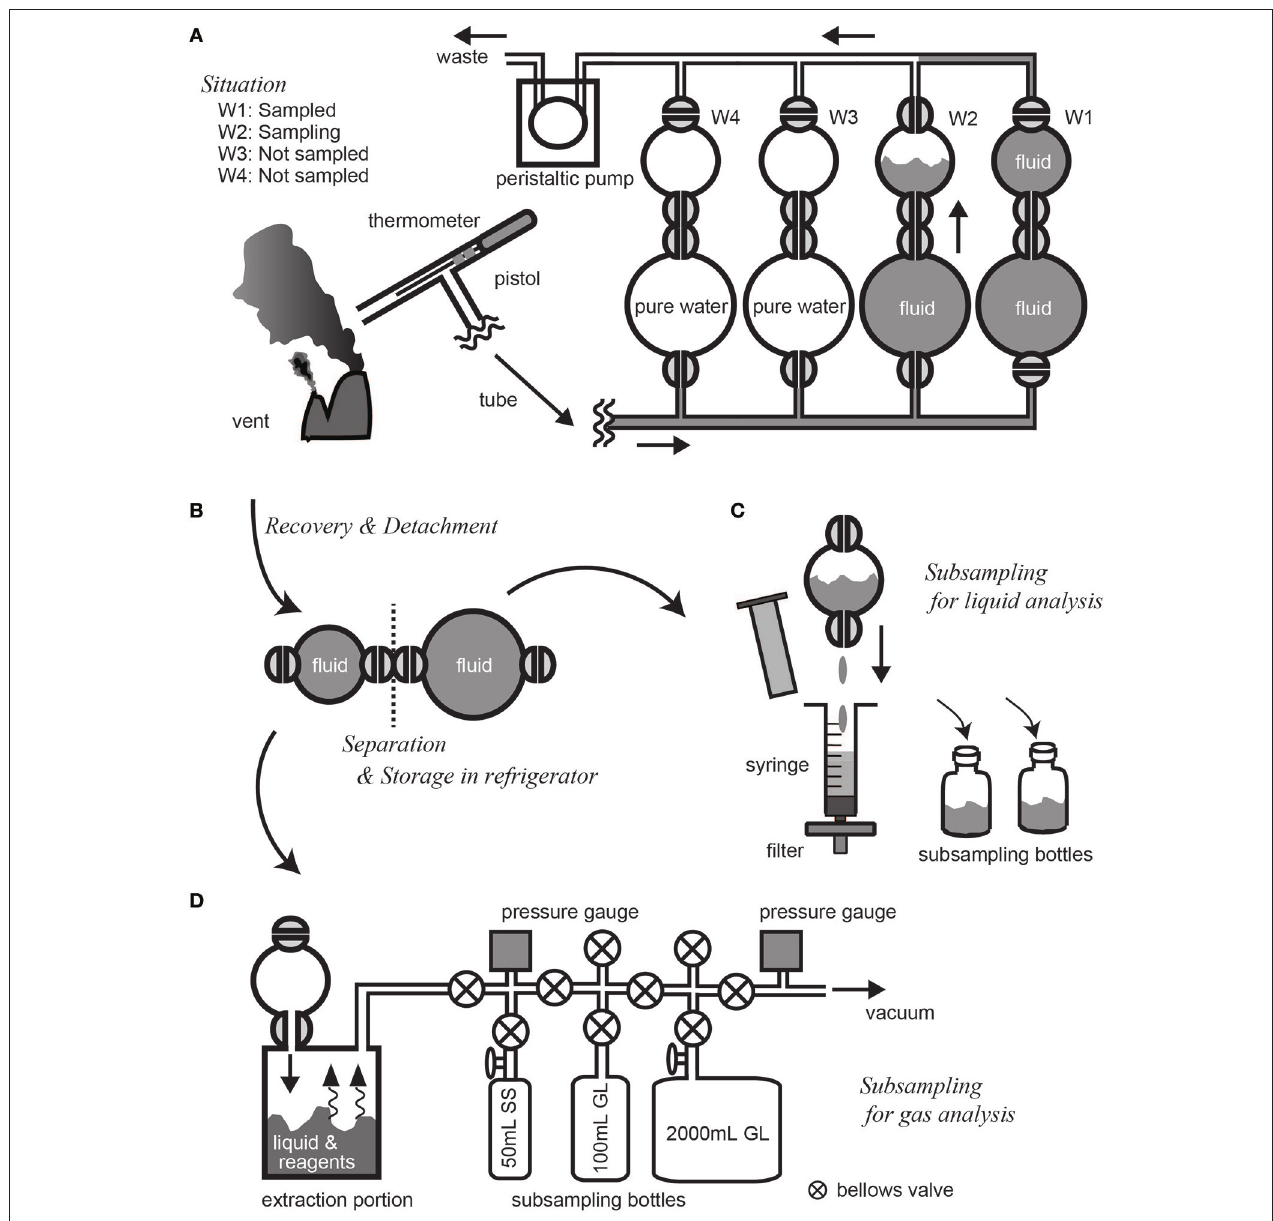
FIGURE 5 | Illustrated walk-through of deep-sea geofluid sampling and on-board subsampling procedures using the WHATS-3. (A) Presents the situation within the second bottle at the time of geofluid sampling. (B) Shows bottle separation procedure for storage in refrigerator after sample recovery on board. (C,D) indicate methods of subsampling for liquid and gas analyses,